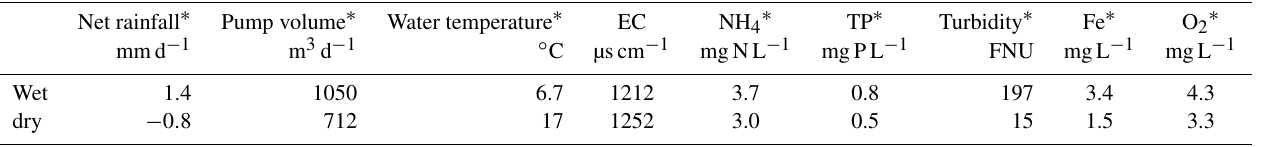
Table 2. The mean of each parameter and the significance for the wet and dry seasons. Net rainfall